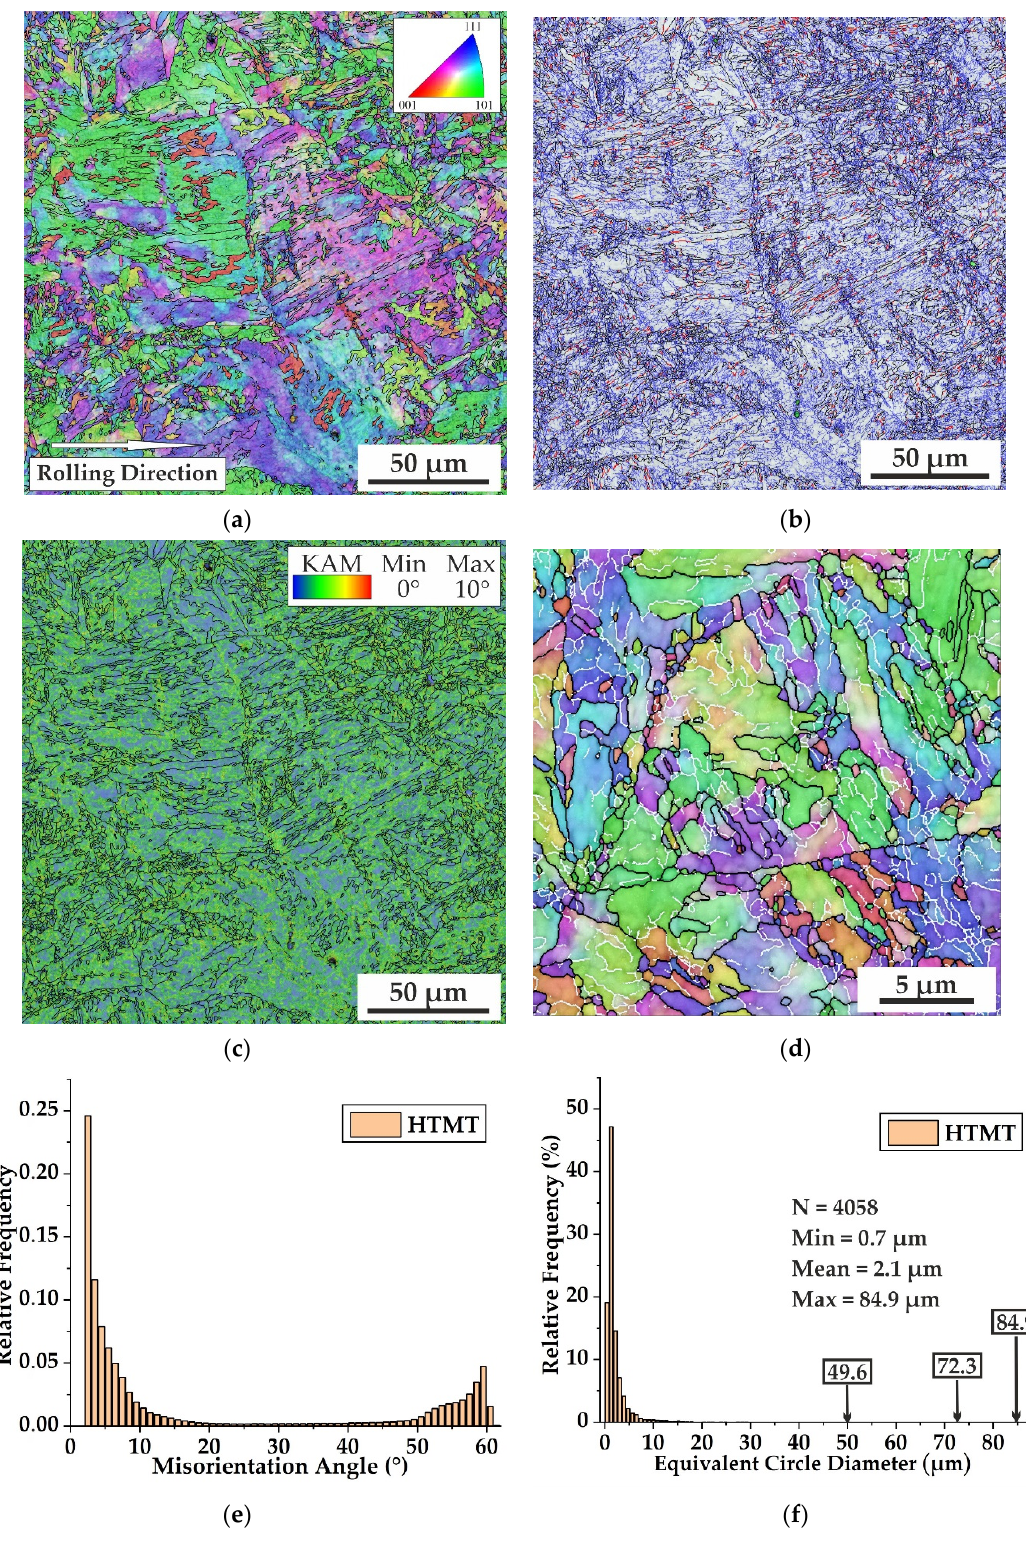
Figure 2. SEM EBSD images of steel microstructure after HTMT in the section parallel to the rolling plane. Orientation map ( a ). Phase map ( b ). KAM map ( c ). Magnified orientation map ( d ). Grain misorientation distribution ( e ). Histogram of grain size distribution ( f